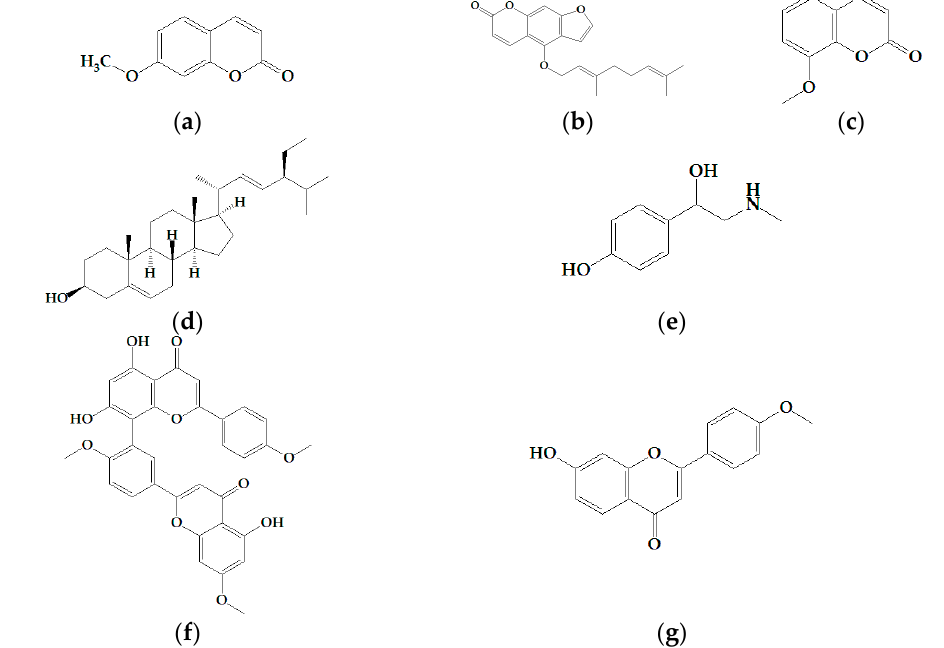
Figure 1. Structural formulae of ( a ) 7-methoxycoumarin; ( b ) bergamottin; ( c ) 8-methoxycoumarin, ( d ) stigmasterol; ( e ) synephrine; ( f ) sciadopitysin; and ( g ) pratol.